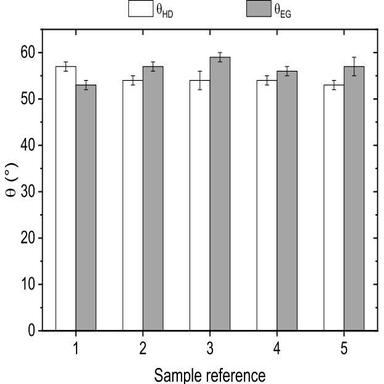
Repeatability of the measurement of HD and EG contact angles for pristine single CF strand referenced as n°1–5.